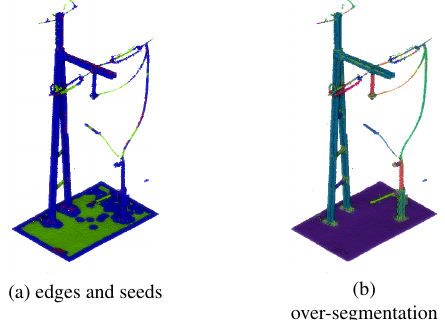
Figure 6. Point selected from the process described in section 3.1.2 in (a). Seeds are shown in green, while edges are shown in red. Over-segmentation generated by the proposed region growing algorithm in (b), colourized with random colours. Objects correspond to geometrically coherent regions. One can see that cables, ground patches, poles and objects of primitive forms are correctly labelled. More complex structures such as steel beam are regrouped into one